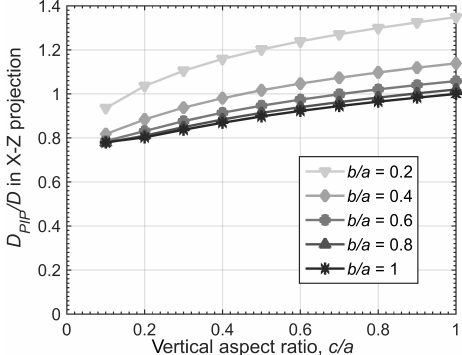
Figure 2. The ratio of the diameter observed by PIP, D PIP , to vol- ume equivalent diameter D